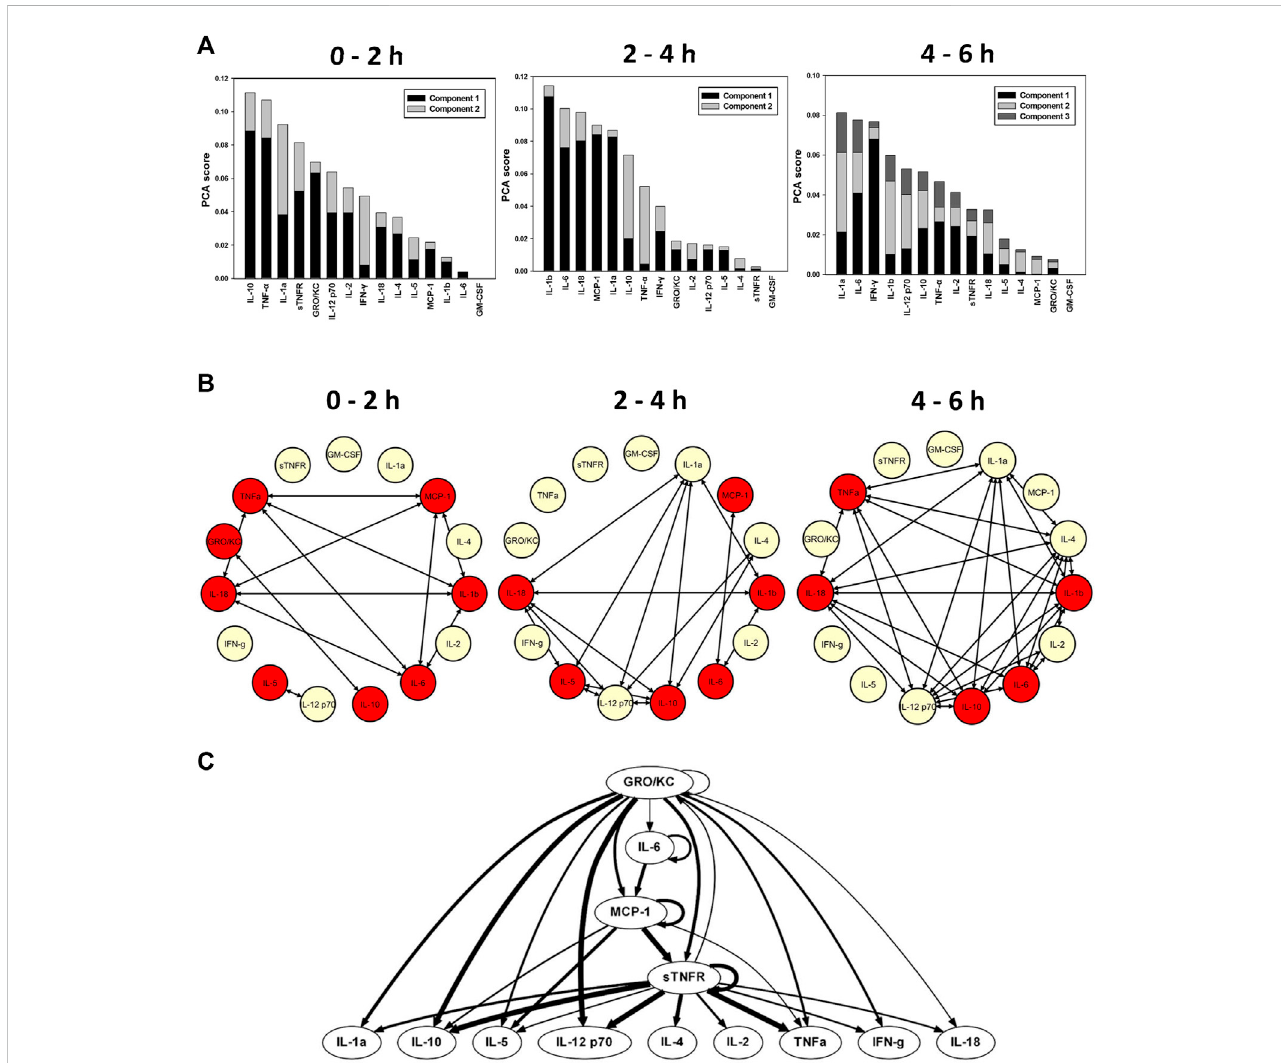
Early role of constitutively delivered sTNFR on the dynamics of systemic in fl ammation in endotoxemic rats. Rats (n = 7) subjected to LPS infusion for 4 h were cannulated for a further 2 h (total of 6 h experimental time) to bioreactor producing sTNFR constitutively (CMV--driven). (A) Principal component analysis (PCA) was carried out over three time intervals (0 – 2, 2 – 4, and 4 – 6 h) using time course data of circulating in fl ammatory mediators. PCA pointed to a differential role of in fl ammatory mediators that characterizes the in fl ammatory response over the three time intervals. (B) Dynamic network analysis (DyNA) of circulating in fl ammatory mediators was performed during three time frames, 0 – 2, 2 – 4, and 4 – 6 h, as described in Materials and Methods. In fl ammatory mediators encircled with a red circle represent mediators (TNF-- α , IL--6, MCP--1, IL--2, IL--5, IL--10, IL--18, IL--1 β , IFN-- γ , GRO/KC, and sTNFR) that were statistically signi fi cantly altered by One--way ANOVA ( p < 0.05) with at least one connection to another mediator. (C) Dynamic Bayesian Network (DyBN) inference of the in fl ammatory mediators over the 6 h study period suggested that central nodes consisted of the GRO/KC, MCP--1, and sTNFR. The thickness of each arrow denotes the relative algorithmic con fi dence in a given interaction between